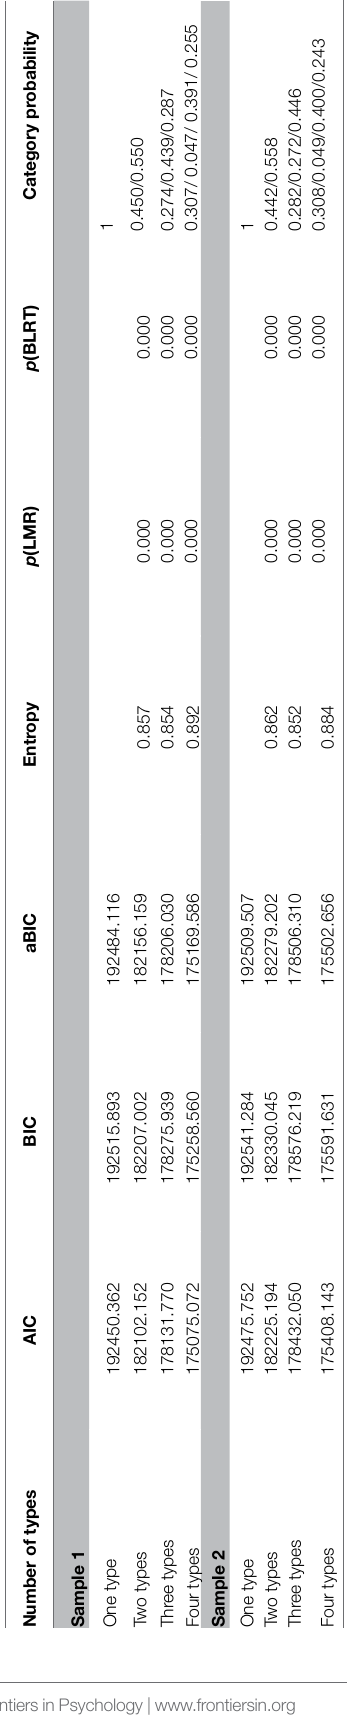
FIGURE 2 | Potential profile of the three-class model ( n 1 =